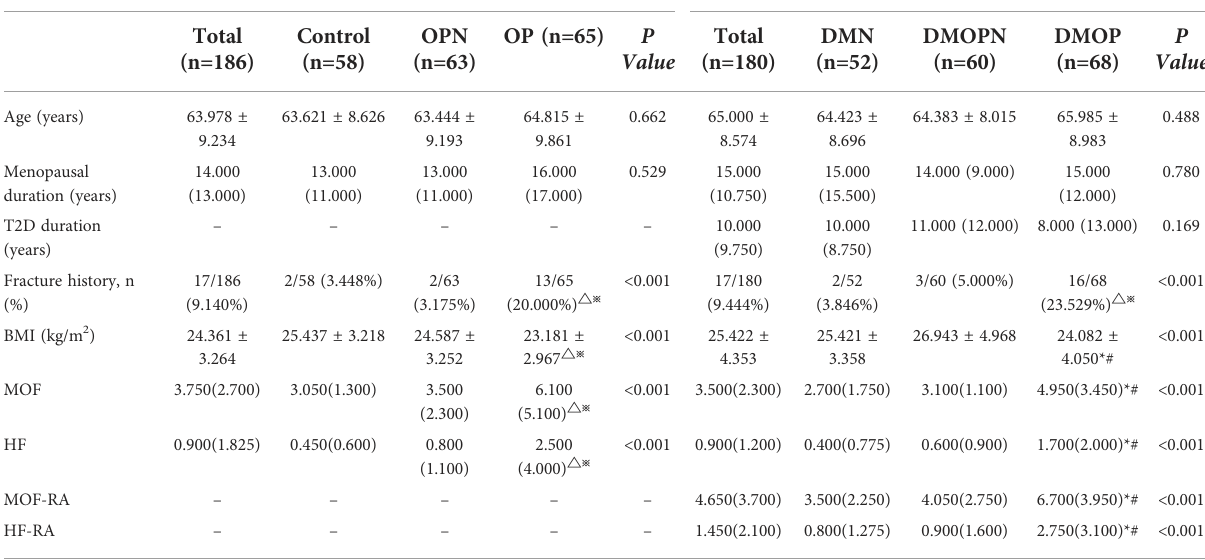
TABLE 1 Baseline characteristics of the study